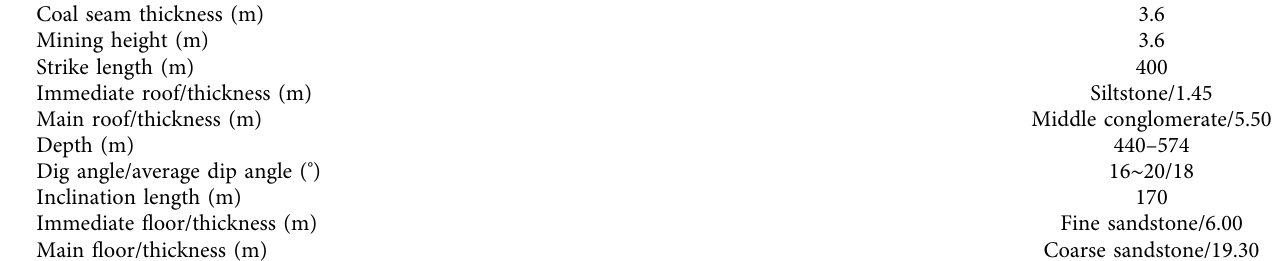
Table 1: Basic parameters of the 43073 working face.